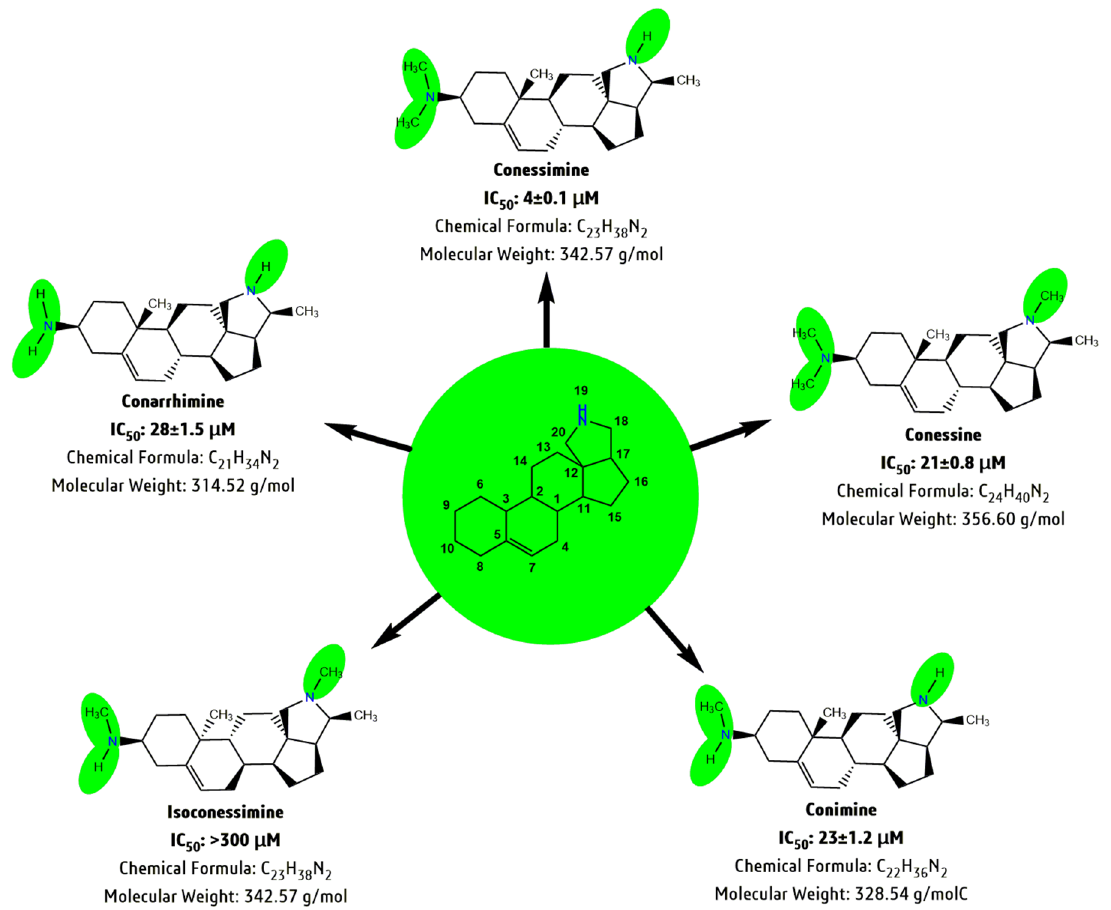
Figure 3. Schematic representation of the Structural-Activity-Relationship (SAR) of the steroid-alkaloid class of phytoconstituents; conarrhimine, conessimine, conessine, conimine and isoconnessine, isolated from H. pubescens. IC 50 expressed in µ M, range of 4 to > 300 for acetylcholinesterase (AChE) / neuroprotective activity.